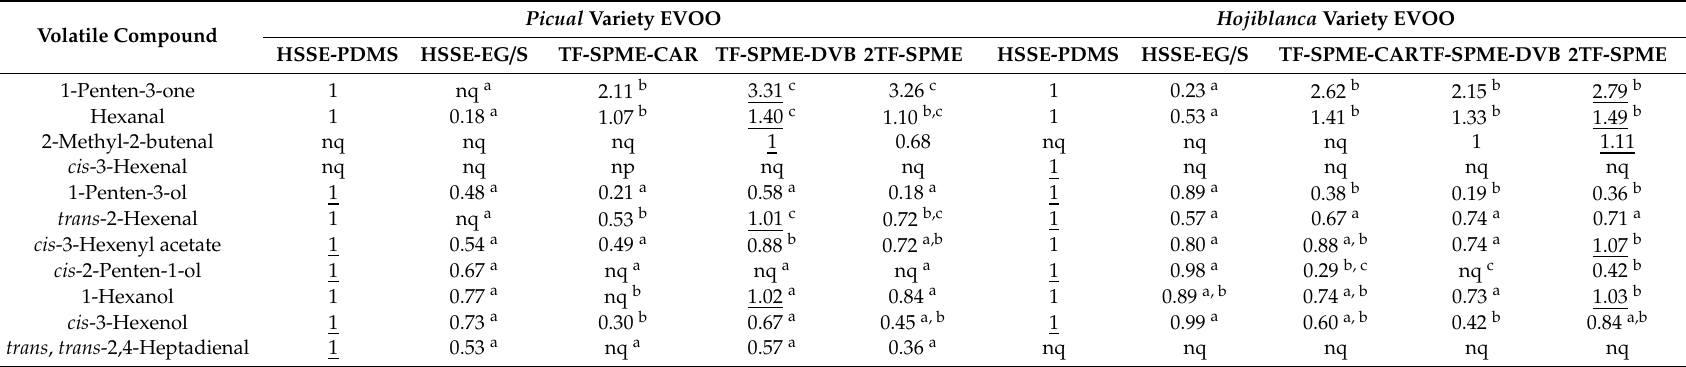
Table 1. Comparison of volatile compounds by di ff erent extraction methods. Peak relative area normalized with respect to